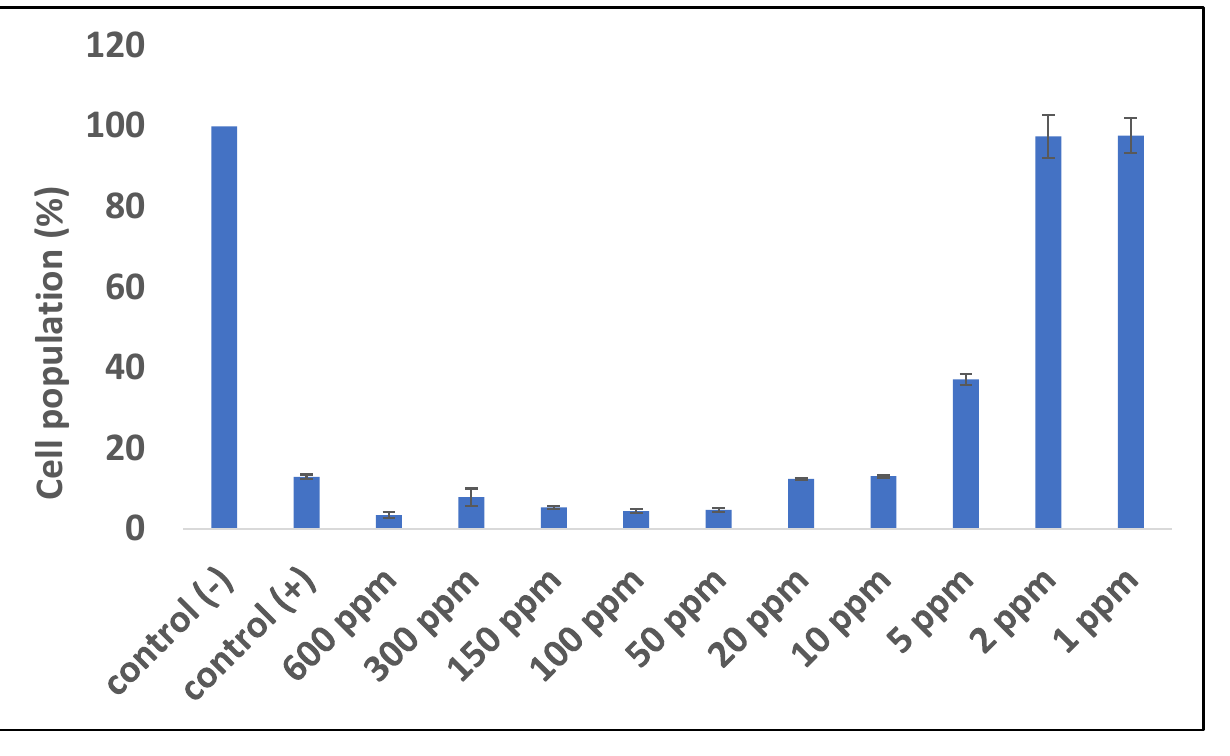
Figure 1. Quantitative analysis of the impact of B. cernua extract addition to malarial parasite- infected erythrocytes. Control ( − ): erythrocytes; control (+): erythrocytes + P. falciparum ; treatment: erythrocytes + P. falciparum + methanol extracts at various concentrations (600 ppm, 300 ppm, 150 ppm, 100 ppm, 50 ppm, 20 ppm, 10 ppm, 5 ppm, 2 ppm, or 1 ppm). All of the data except for 1 and 2 ppm extract were considered significantly differ compared to the control ( − ) ( p <0.05).